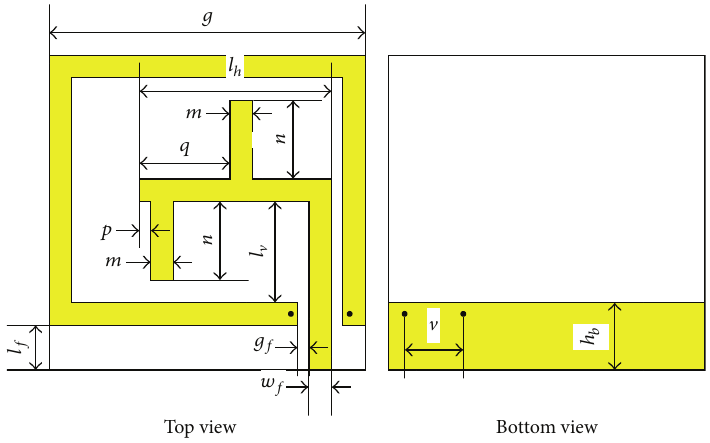
Figure 1: Wide-gap antenna loaded with Y-shaped metal strip.